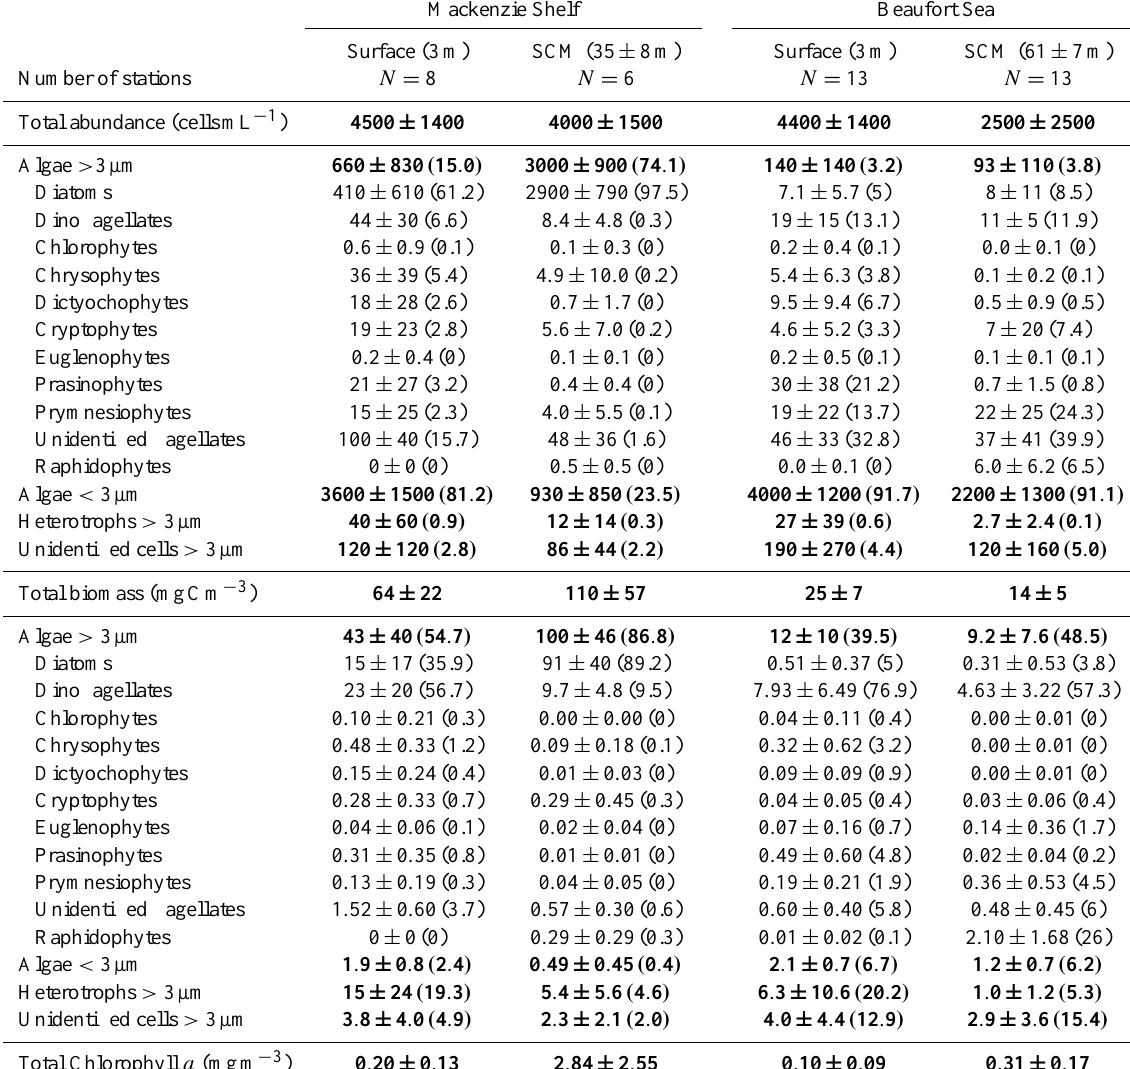
Table 2. Abundance and carbon biomass (mean ± SD) of the major protist groups in surface and subsurface chlorophyll a maximum (SCM) depth of the Mackenzie shelf and in deep waters of the Beaufort Sea. The mean percent contribution of each protist group to the total cell abundance and total carbon biomass is indicated in parentheses. Large ( > 3µm) and small ( < 3µm) cells were counted by light microscopy and flow cytometry, respectively. The average cell abundance and carbon biomass are in bold characters. Total chlorophyll a concentration (mean ± standard) is indicated at the bottom of the table. The heterotrophic group is composed of flagellated